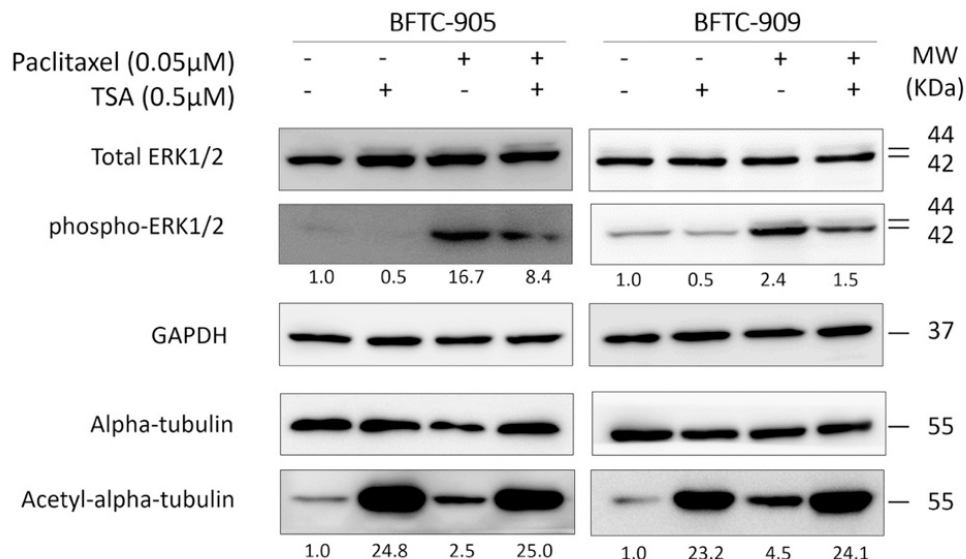
Figure 4. Western blotting for the ERK pathway and acetylation. Cells were treated with 0.5 µ M TSA or 0.05 µ M paclitaxel for 24 h, and cell lysates were collected for further Western blotting. An increase of phosphor-ERK1/2 suggested a potential drug-resistant phenomenon in the paclitaxel-only group; however, phosphor-ERK1/2 declined in the TSA alone and combined groups, suggesting a potential antiresistance-like effect. To confirm acetylation under the TSA treatment, acetyl-alpha-tubulin served as an acetylation marker. In both the TSA and combination groups, acetyl-alpha-tubulin increased robustly, indicating the effect of the histone deacetylation inhibitor.